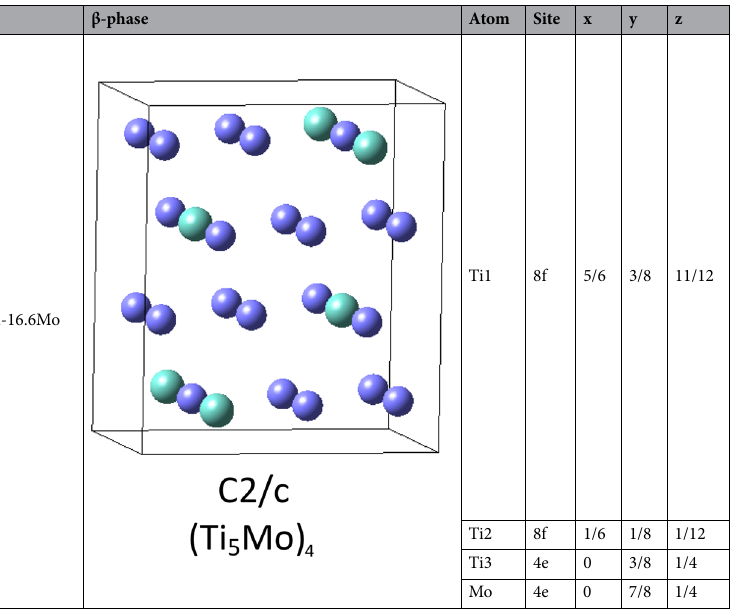
Table 2. CE predictions of stable β-phase structures for the Ti–Mo binary. The blue and green atoms are respectively Ti and